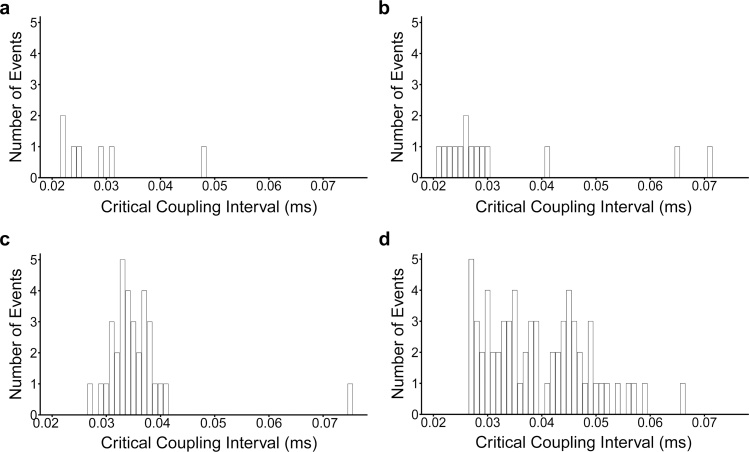
Stratification of the occurrence of AT episodes by critical coupling intervals in young ((a), (c)) and old ((b), (d)), WT ((a), (b)) and Pgc-1β−/− hearts ((c), (d)). Pgc-1β−/− hearts display vulnerability to arrhythmia earlier, and through wider range of S1-S2 coupling intervals.